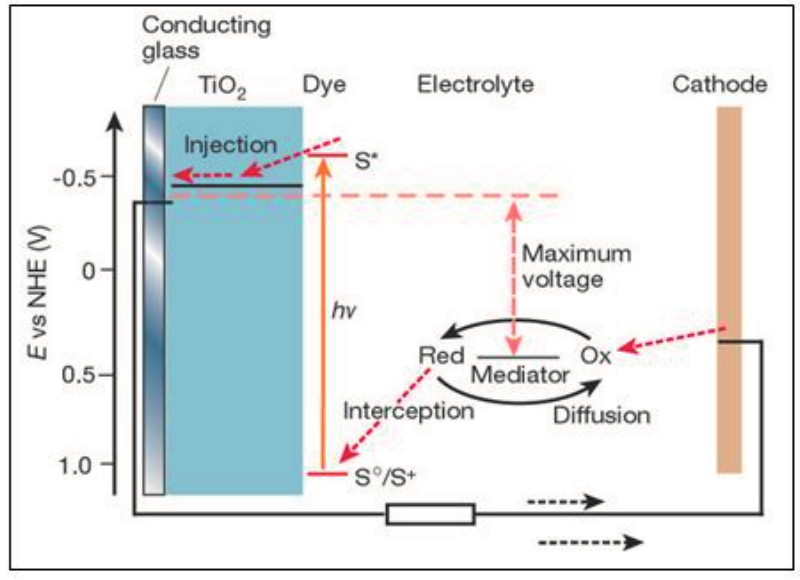
Figure 6. Working principle of dye-sensitized solar cell (DSSC) (reproduced from [76] with permission of Nature Publishing